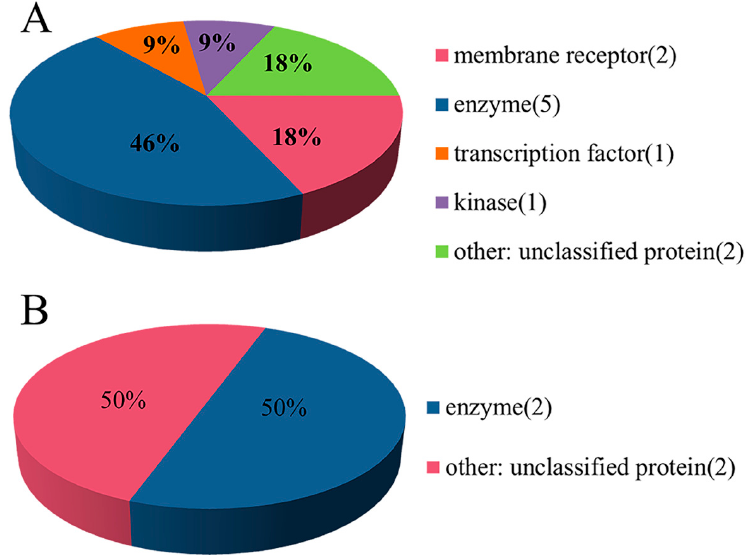
Figure 3. Target classification of the HIV-1 ( A ) and HCV ( B ) data sets.